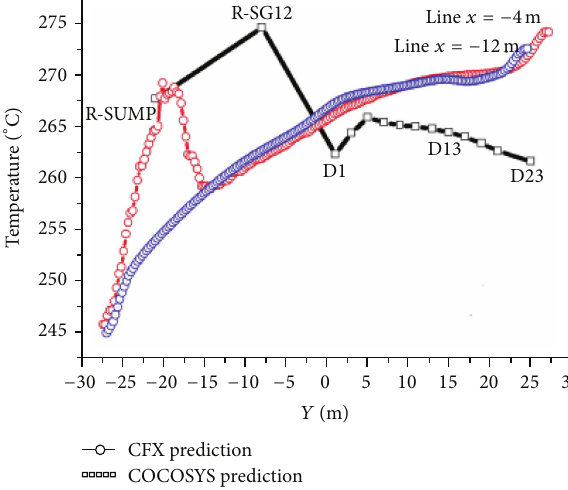
Figure 4: Comparison of temperature distribution at 10106s.